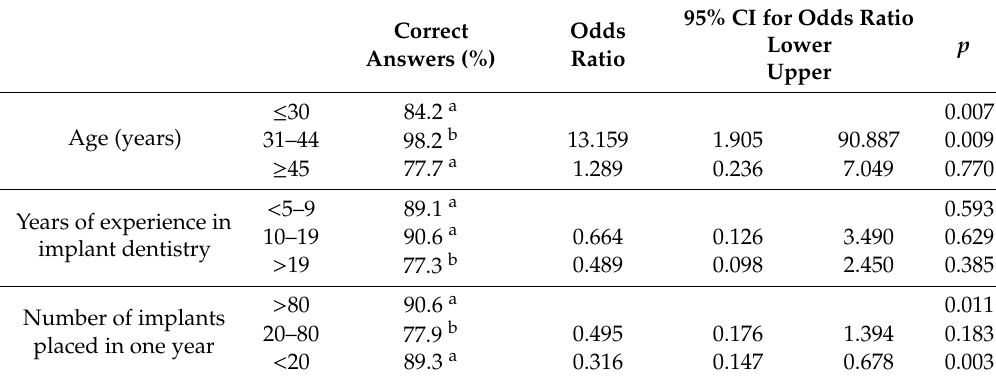
Multivariable analysis considering the correct answers on the origin of retrograde peri-implantitis as the outcome variable.